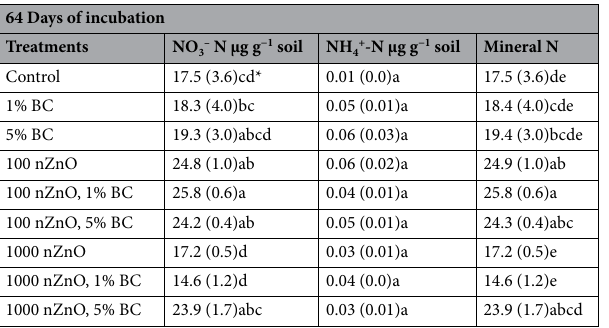
Table 2. Effect of nZnO & BC on NO 3– N, NH 4+ -N and mineral N. Different letters within a column indicate significant difference between means at 95% confidence interval. The brackets contain standard errors of means (n = 3).